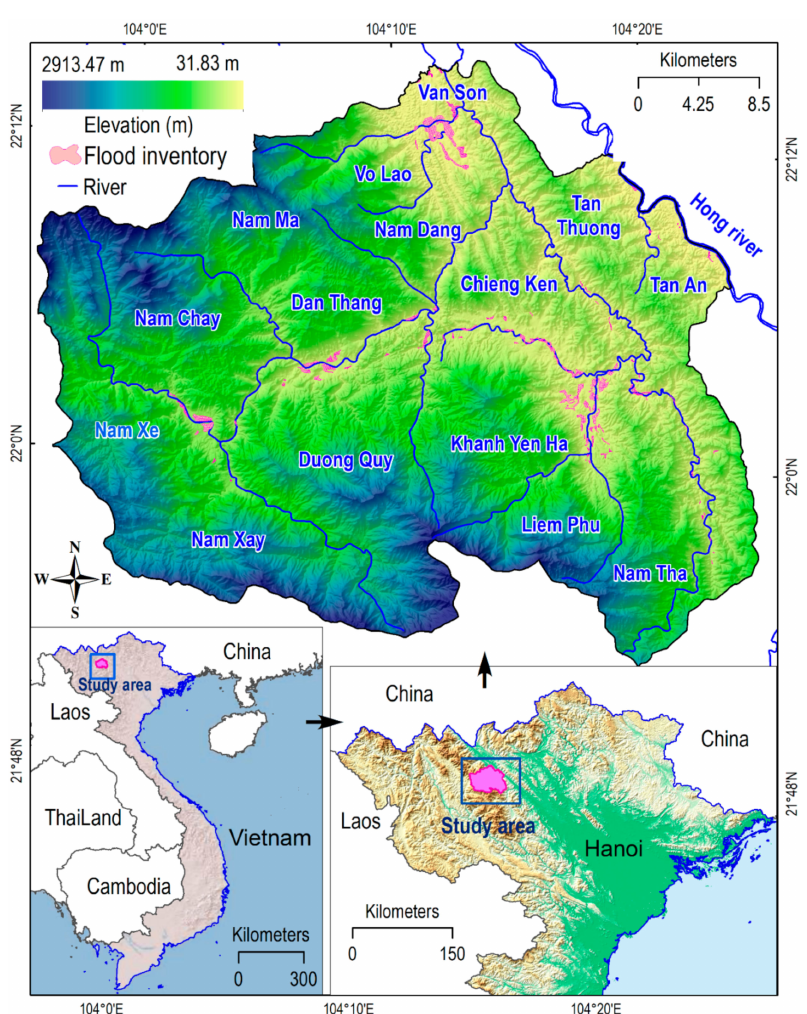
Figure 1. Location map of the Van Ban district and flooded